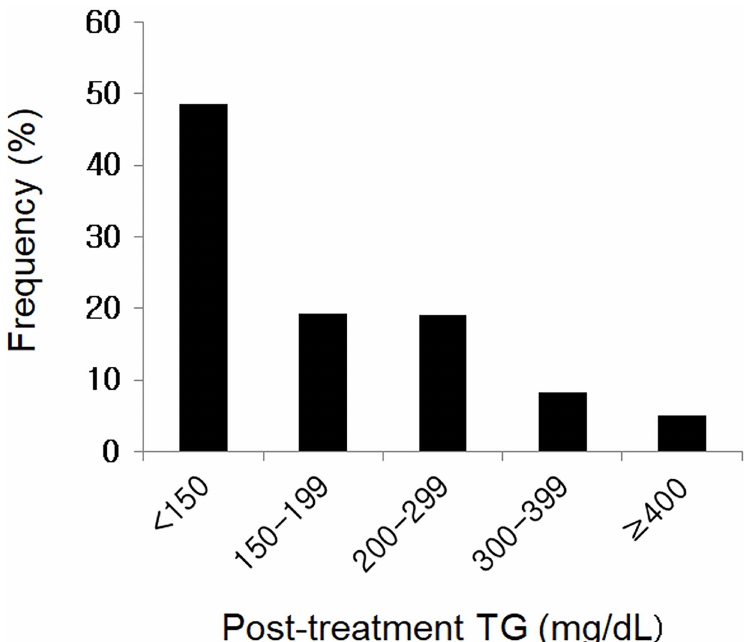
Fig 1. Distribution of post-treatment TG levels in the study population (n = 1153). TG: triglyceride.